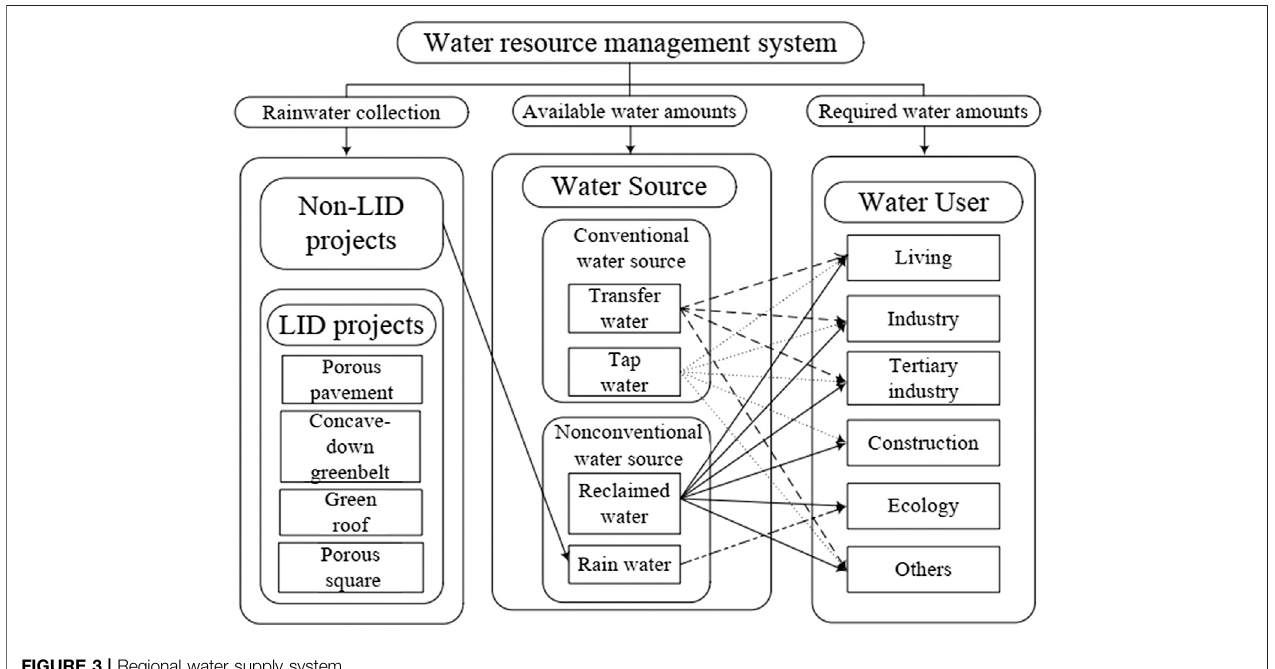
FIGURE 3 | Regional water supply